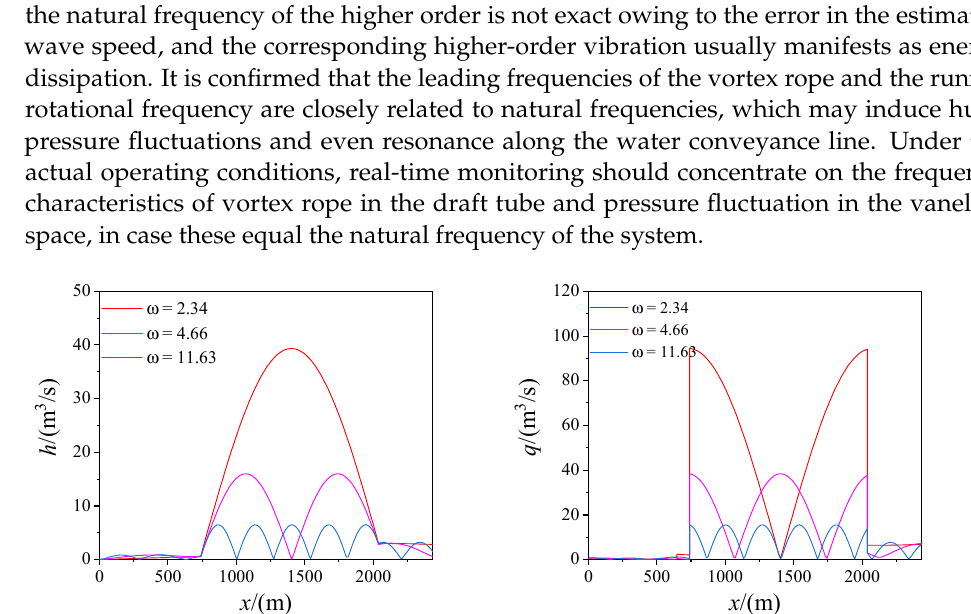
Figure 10. Vibration mode shapes.